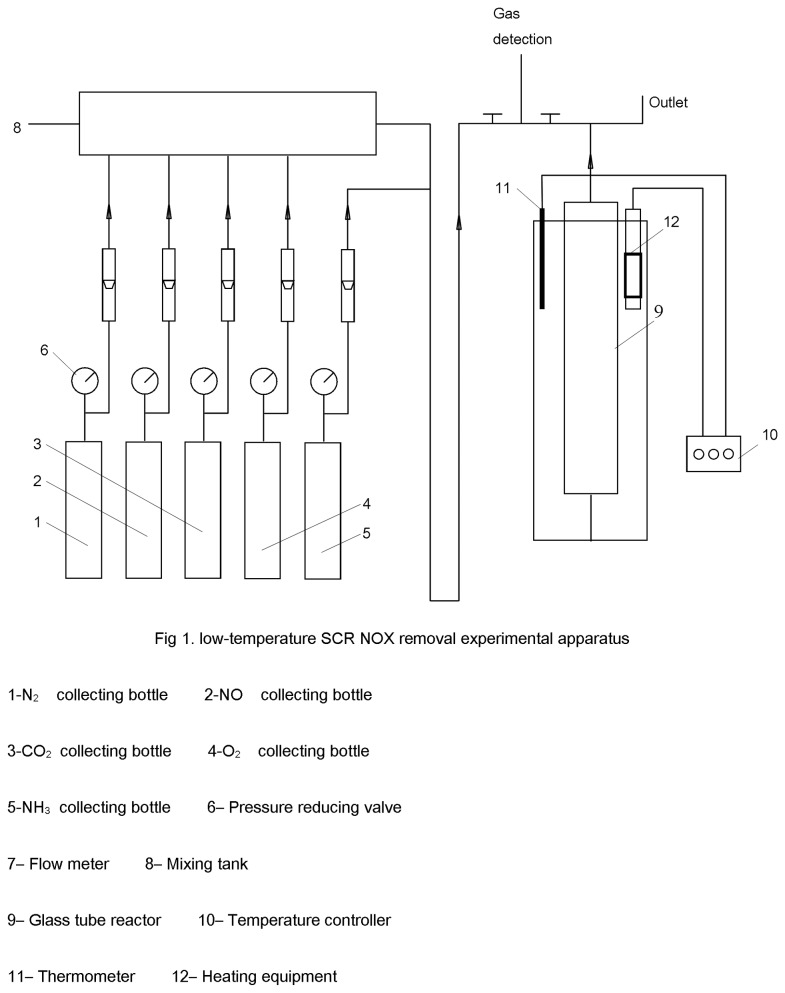
Low-temperature SCR NOx removal experimental apparatus.